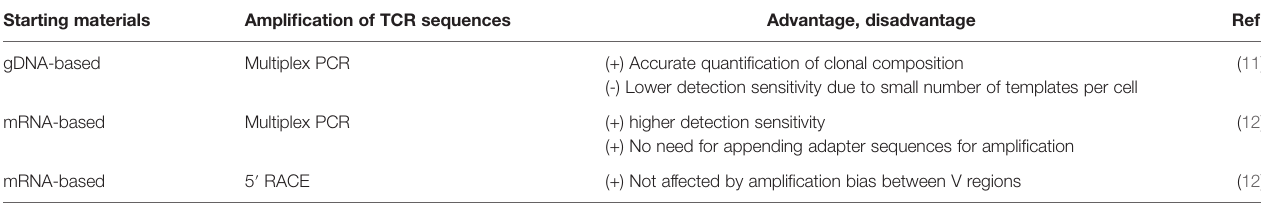
TABLE 1 | Classi fi cations of TCRseq methods and their